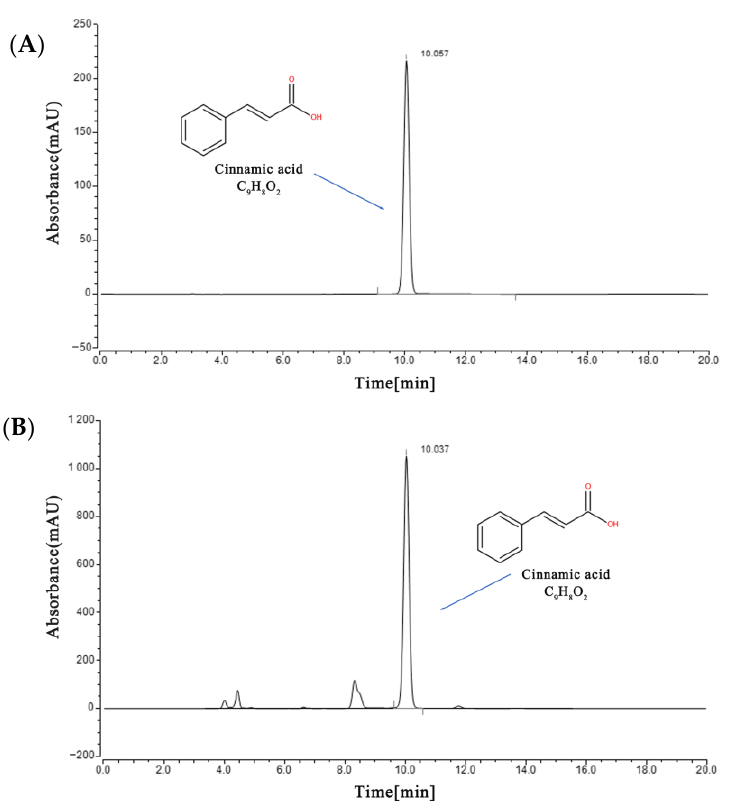
Figure 1. Quantitative analysis of representative chromatograms by HPLC. ( A ) Cinnamic acid (CA) reference substance. ( B ) Storax test substance.